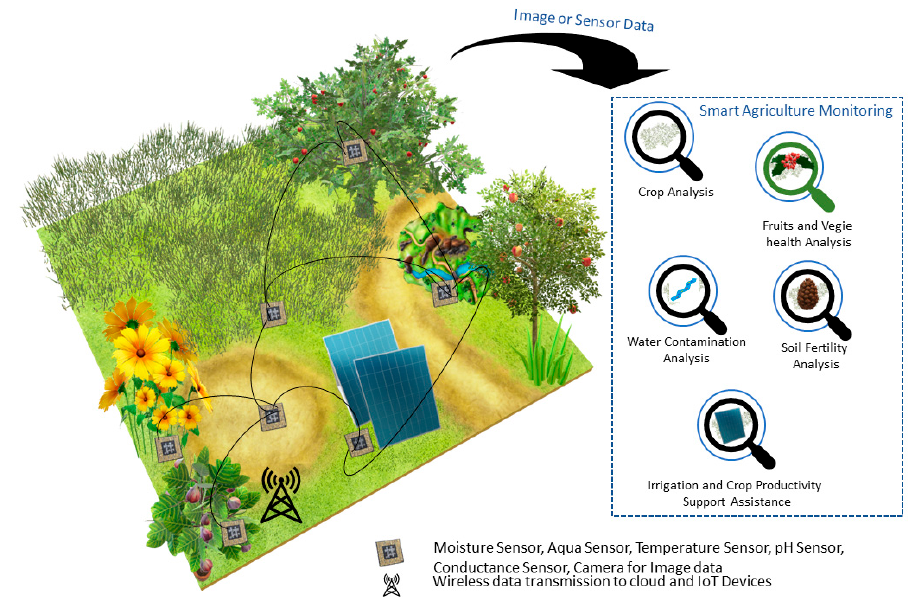
Figure 3. Smart agriculture monitoring system using IoT devices and sensors.